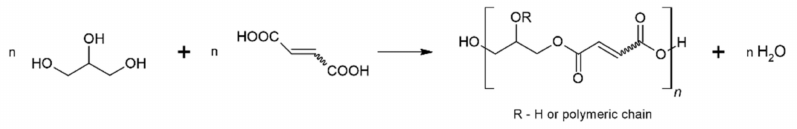
Figure 3. Schematic representation of the synthesis of polyesters with unsaturated bonds.